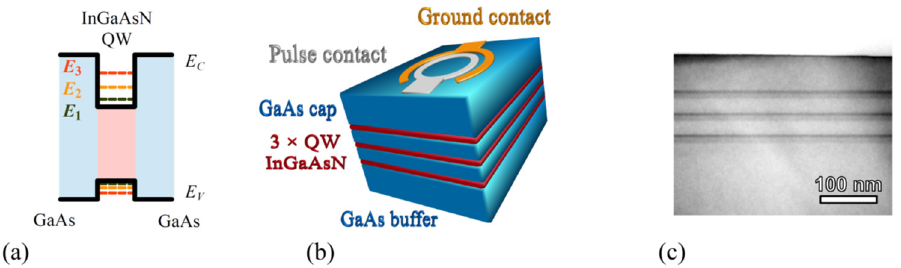
Figure 1. ( a ) Sketch of the energy band diagram of InGaAsN/GaAs quantum well structure. ( b ) A simplified view of the triple quantum well structure and ( c ) micrograph (transmission electron microscopy in the bright field) of fabricated heterostructure.